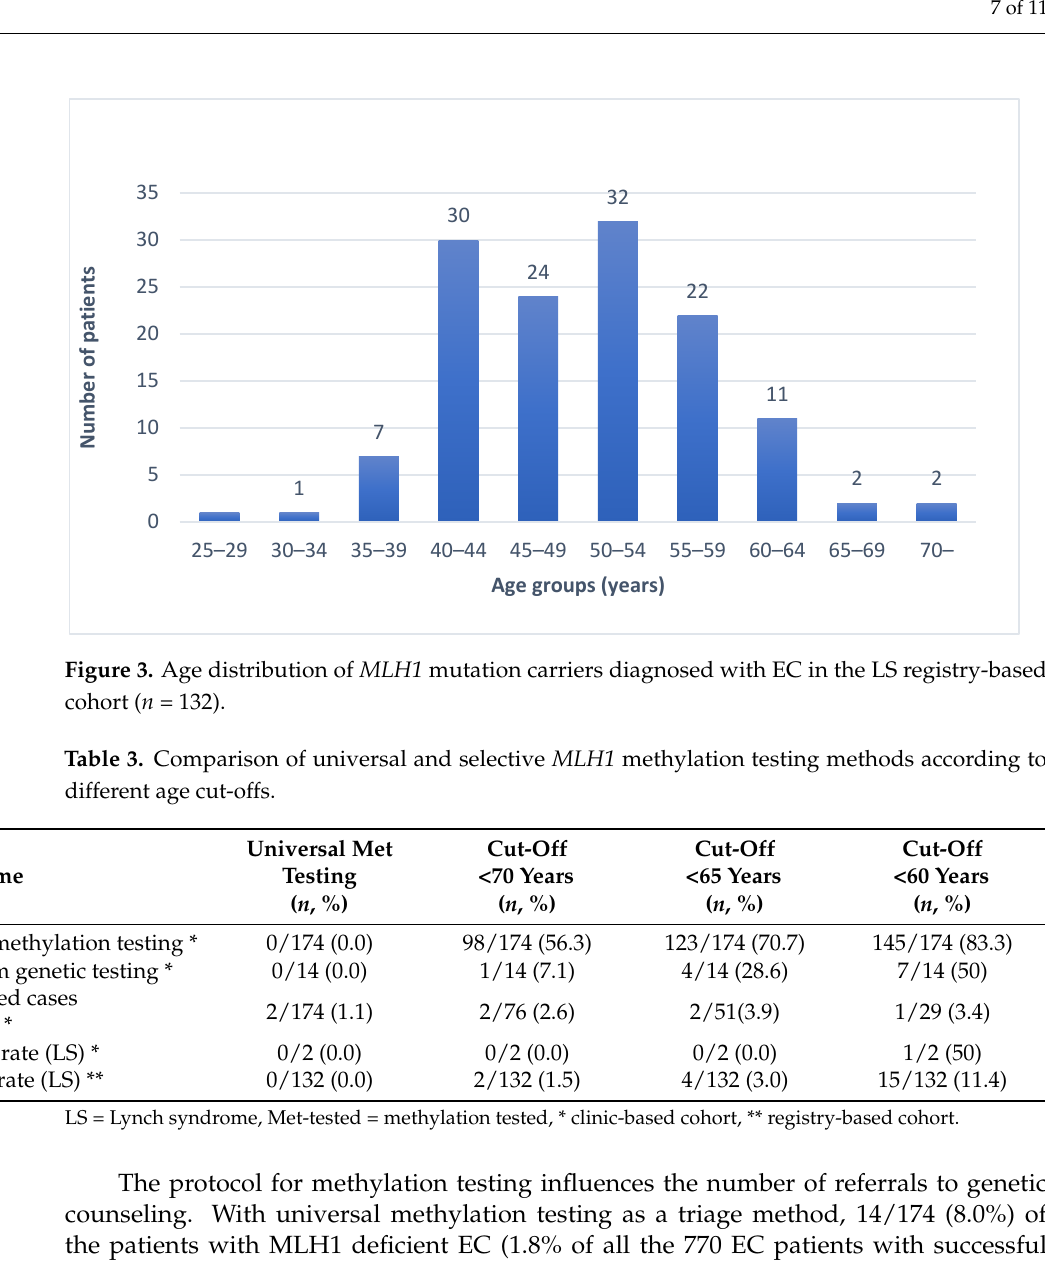
Table 3. Comparison of universal and selective MLH1 methylation testing methods according to different age cut-offs.